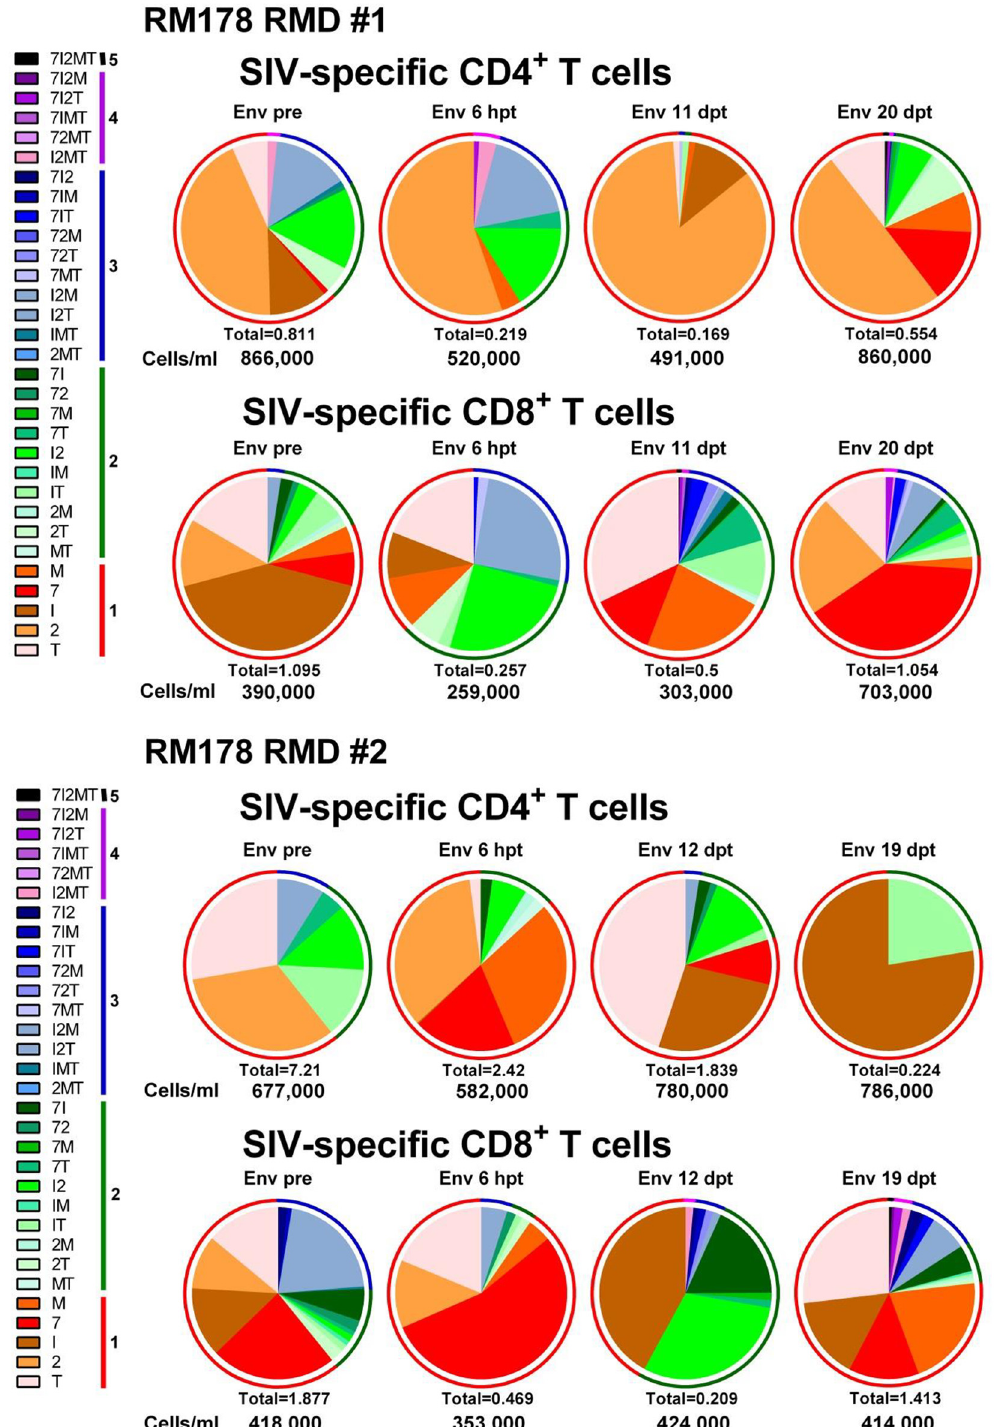
Fig 9. RMD administration does not significantly impact Env SIV-specific T cell responses or functionality in SIVsmmFTq post-treatment controller RM178. Serial monitoring of SIV-specific T cell polyfunctionality after two rounds of RMD administration was achieved by stimulating PBMCs with Env SIVmac239 peptide pools followed by intracellular cytokine staining. Cytokines tested include: TNF- α (T); IL-2 (2); IFN- γ (I); CD107 α (7); and MIP-1 β (M). Data are representative of all RMs. Absolute numbers of CD4 + /CD8 + T cells/ml for each timepoint